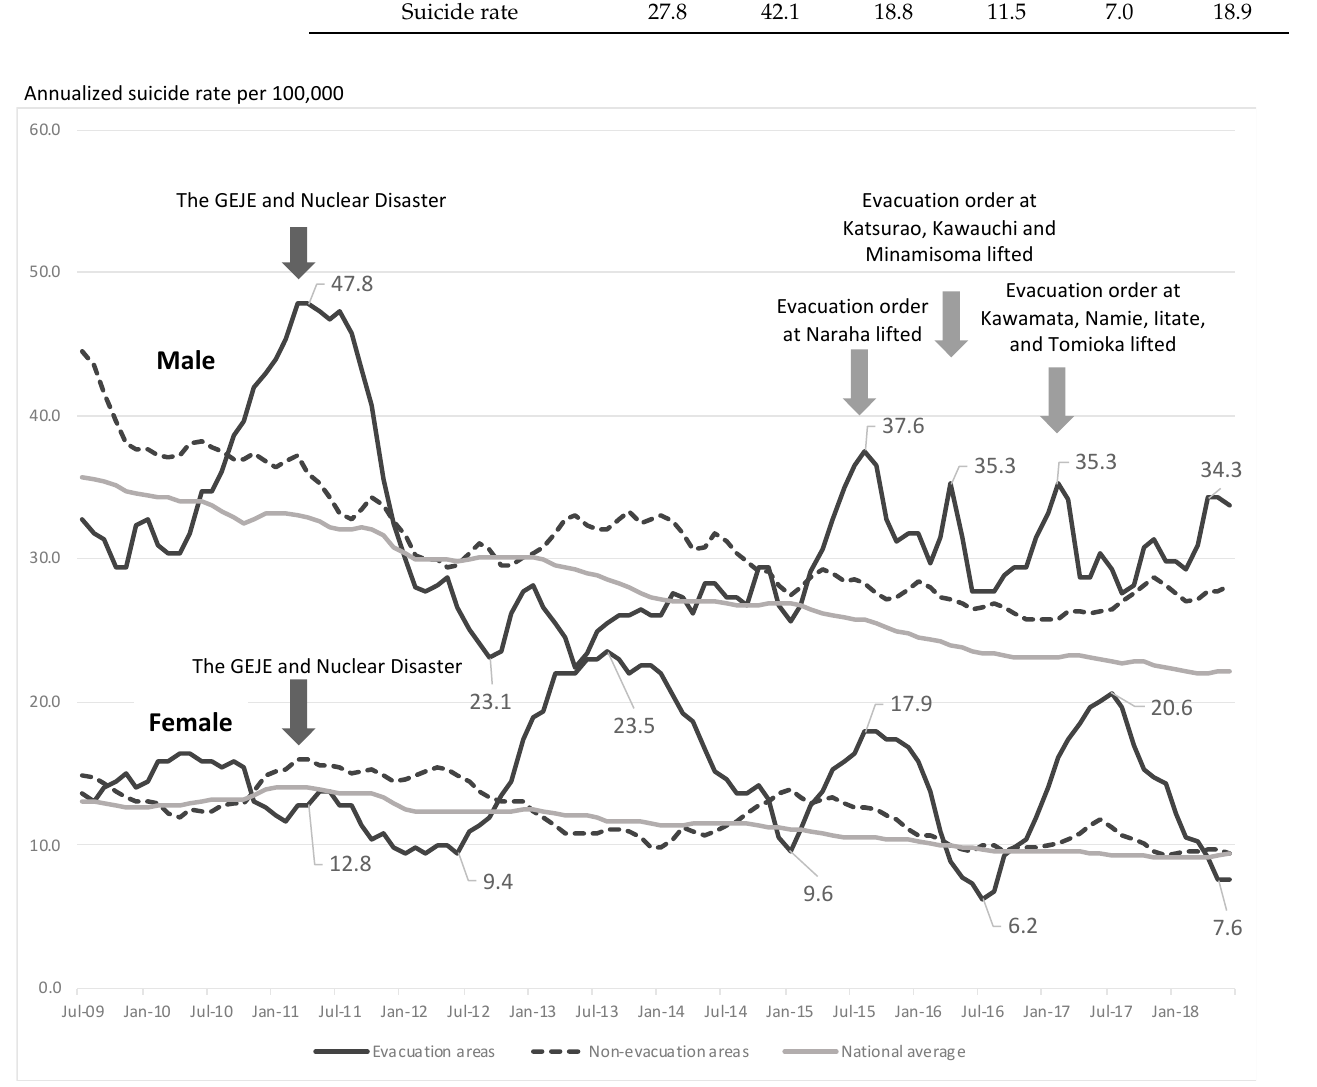
Figure 2. Changes in suicide rates in evacuation and non-evacuation areas by the exponential smoothing time series model. On the other hand, the suicide rate among women in the evacuation areas slightly decreased in the first 1 1 years after the disaster but then increased, surpassing that in the 2 non-evacuation areas and the national average. It peaked at 23.5 per 100,000 at 2 1 years 2 and then declined again over the next 1 1 years. It increased after the first and third lifting 2 of the evacuation order, but about 6 months later than in